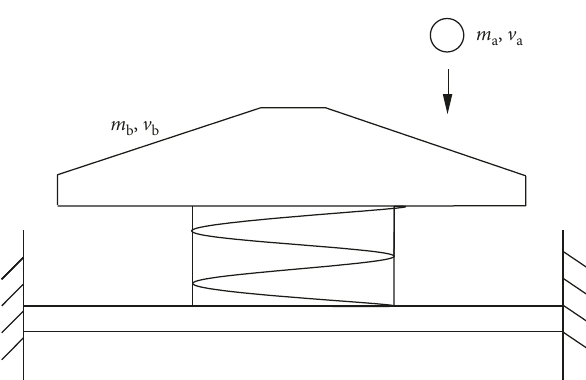
Figure 3: A schematic diagram of the collision process between solid filling material and buffer